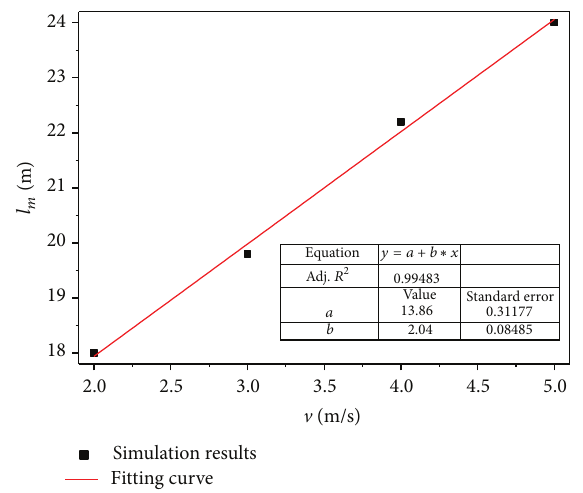
Figure 12: The maximum gas mixture length ( 𝑙 𝑚 ) versus the inlet rate ( V